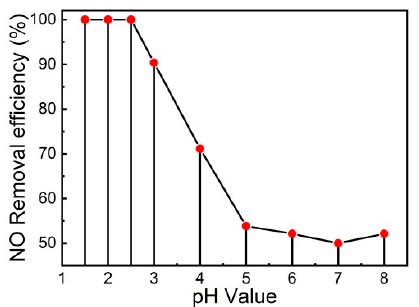
Figure 5. Effect of the pH of the NaClO 2 solution on NO removal efficiency. Reaction conditions: NaClO 2 concentration 0.01 mol/L; temperature 30 °C; NO inlet concentration 500 ppm; N 2 balance, with a total flow rate of 1.5 L/min.